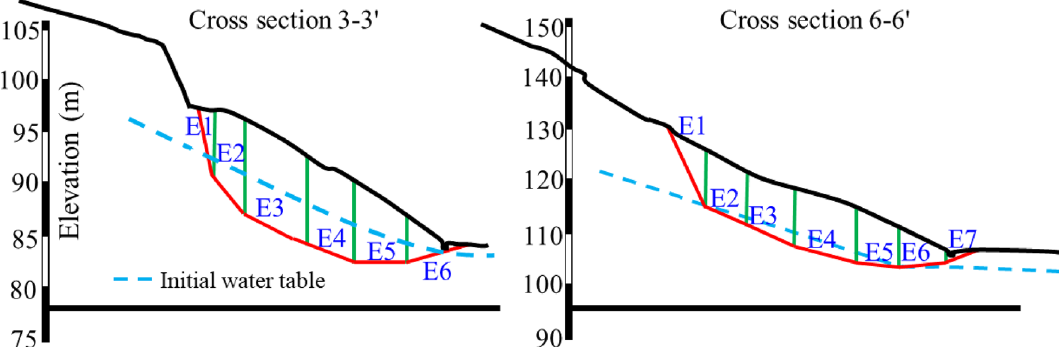
Figure 18. Schematic diagram of soil strip division in cross section 3-3 ′ and 6-6 ′ .